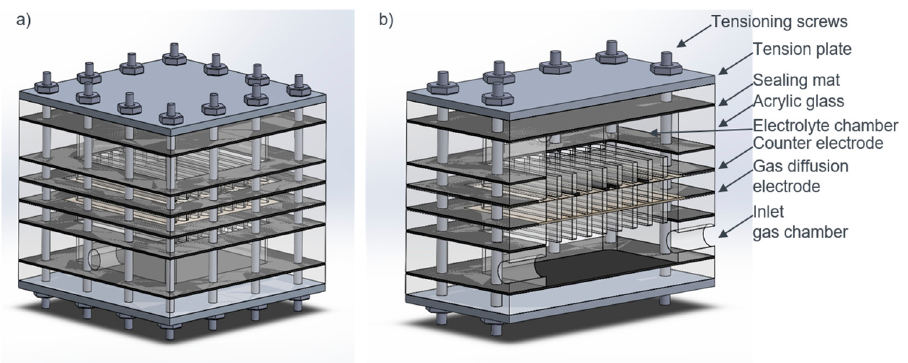
Figure 5. Technical design of a gas diffusion electrode device for the removal of oxygen. ( a ) Full construction. ( b ) Sectional view to show the layers as well as inlets and outlets.